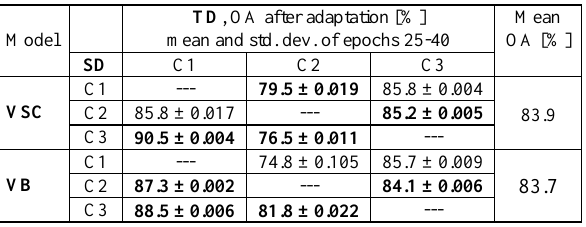
Table 6. Mean OA and standard deviation on the target domain after DA by variant V1 w/o zero-mean convolutions.